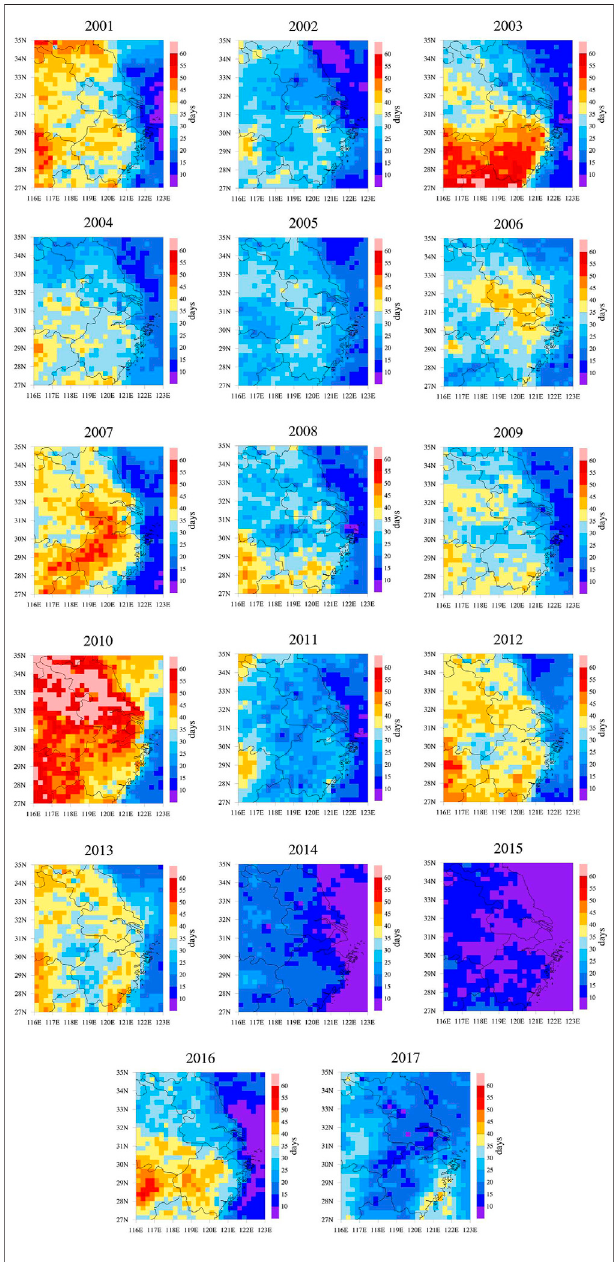
FIGURE 2 | The spatiotemporal distribution of summertime air stagnation days over the YRD from 2001 to 2017.